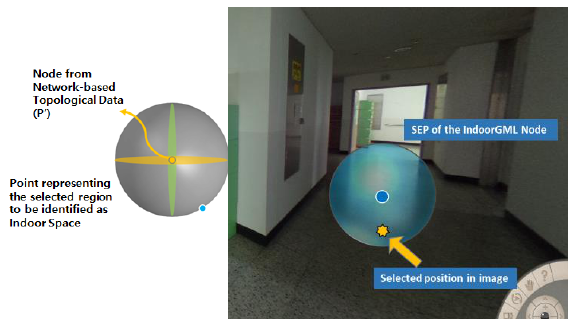
Figure 8. The Spatial Extended Point concept applied to